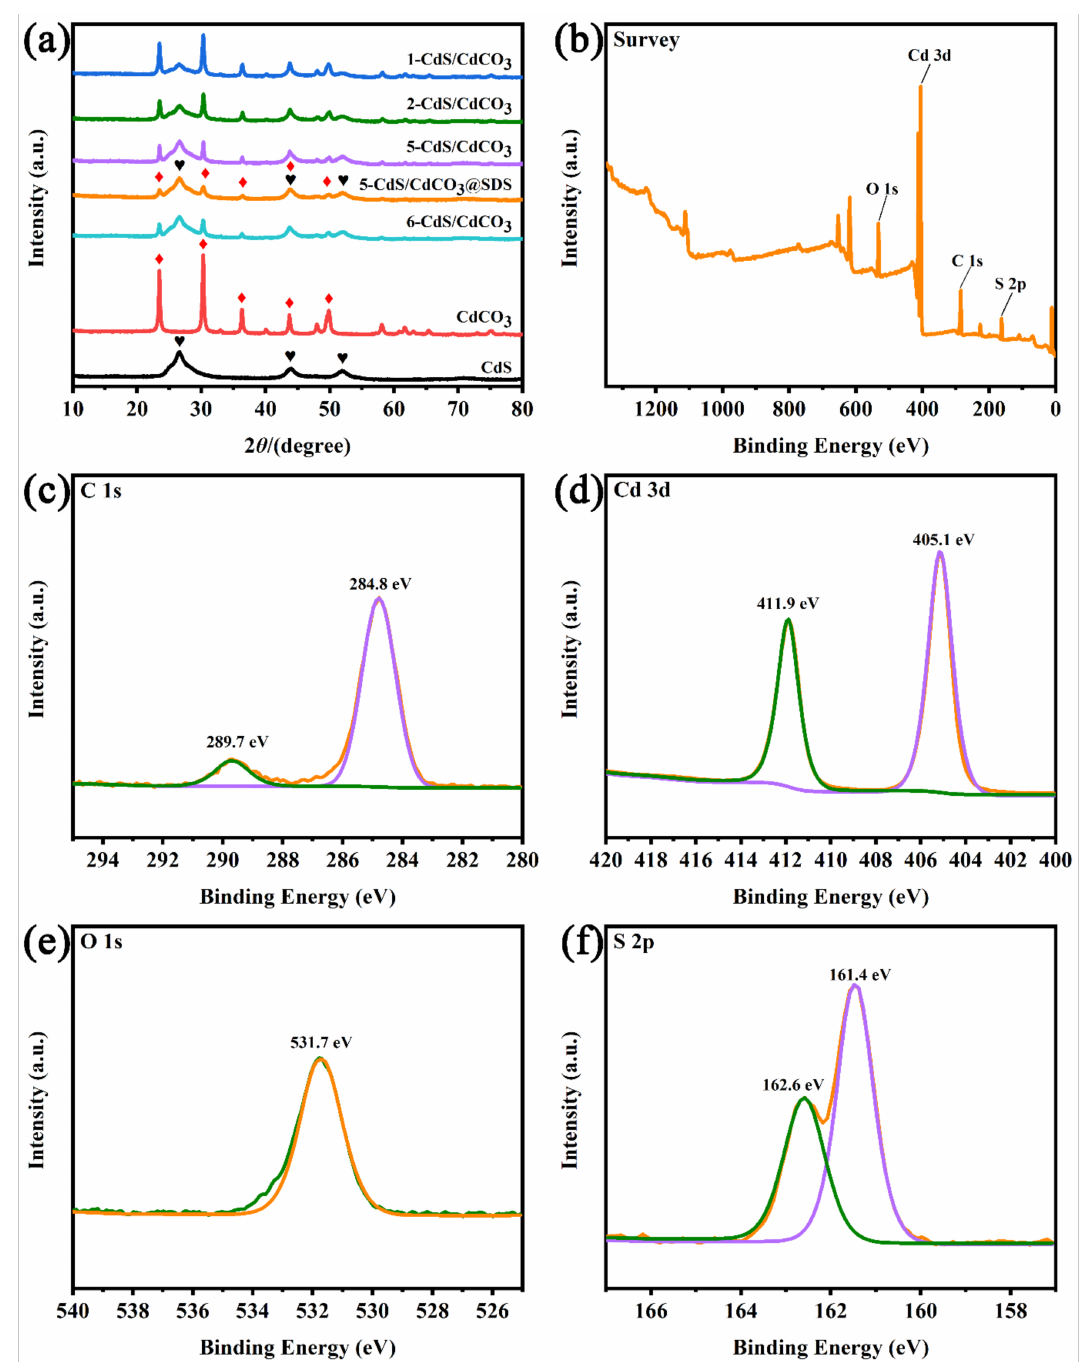
Figure 1. XRD patterns of CdS, CdCO 3 , X -CdS/CdCO 3 and 5-CdS/CdCO 3 @SDS, red rhombus/black hearts correspond to CdCO 3 and CdS respectively ( a ), XPS spectra of 5-CdS/CdCO 3 @SDS sample (survey spectrum) ( b ), C 1 s ( c ), Cd 3d ( d ), O 1 s ( e ) and S 2p ( f